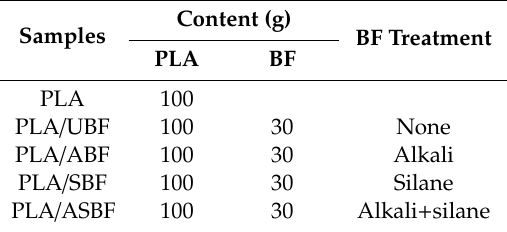
Table 1. Components of PLA / BF